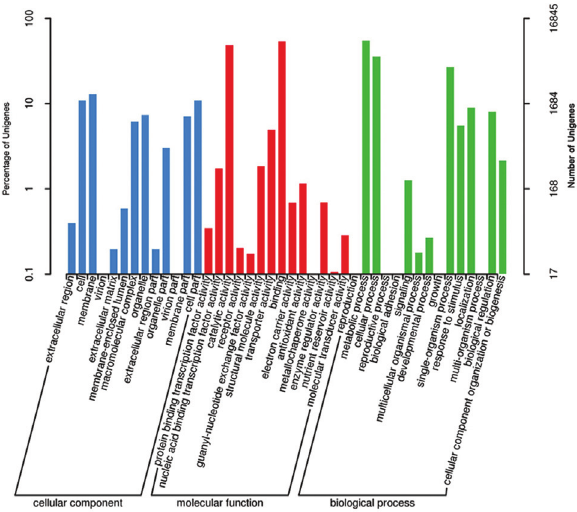
Figure 1 - GO classification of annotated Unigenes.